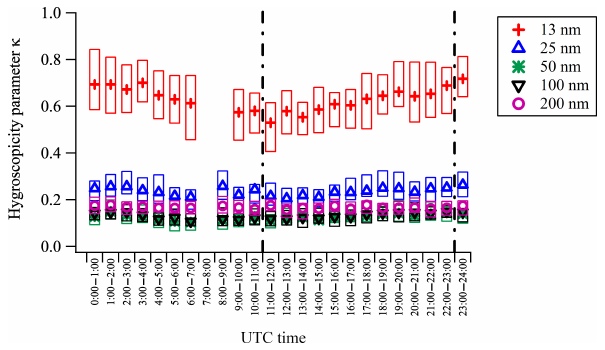
Figure 6. One-hour average hygroscopicity parameters κ for 13, 25, 50, 100, and 200nm particles determined by TDMA from 13 April to 24 May 2013 at SGP. The boxes represent 25–75% ranges of all measurements. The two vertical dashed lines represent 06:00 and 18:00 local time,